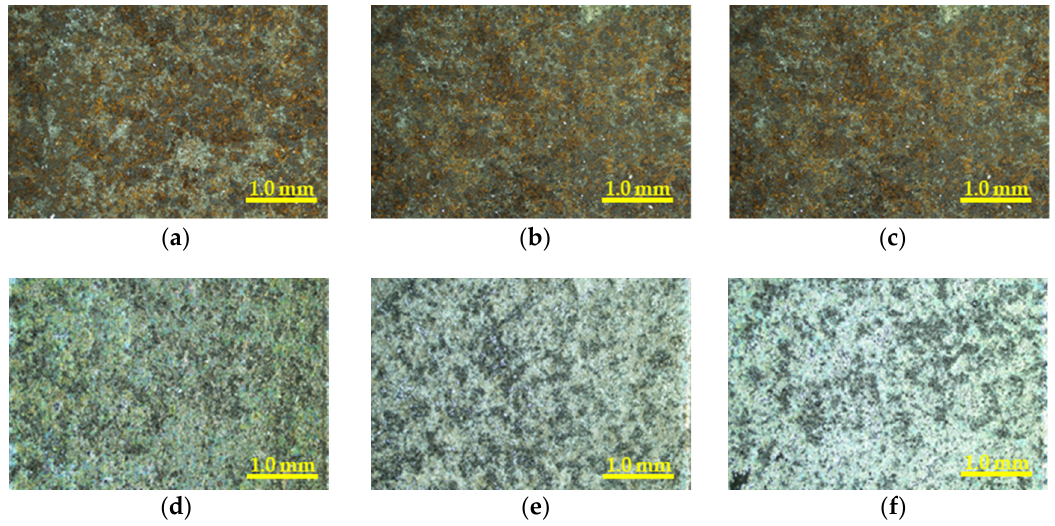
Figure 9. Comparisons of the results of the traditional method and our intelligent method. ( a–c ) The images before laser cleaning; ( d ) the cleaned image of ( a ) using the traditional laser cleaning method; ( e ) the cleaned image of ( b ) using the intelligent laser cleaning method; ( f ) the cleaned image of ( c ) using the intelligent laser cleaning method.